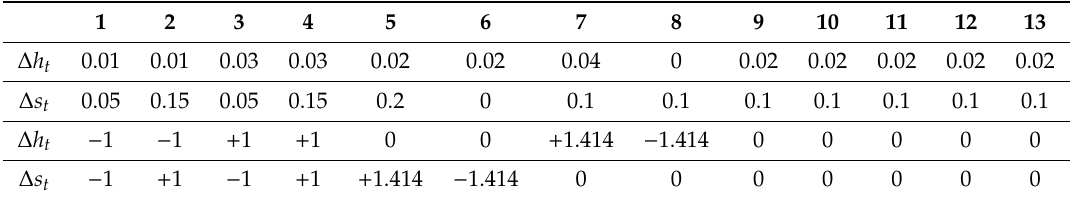
Table 1. Experimental plan with real and coded values.